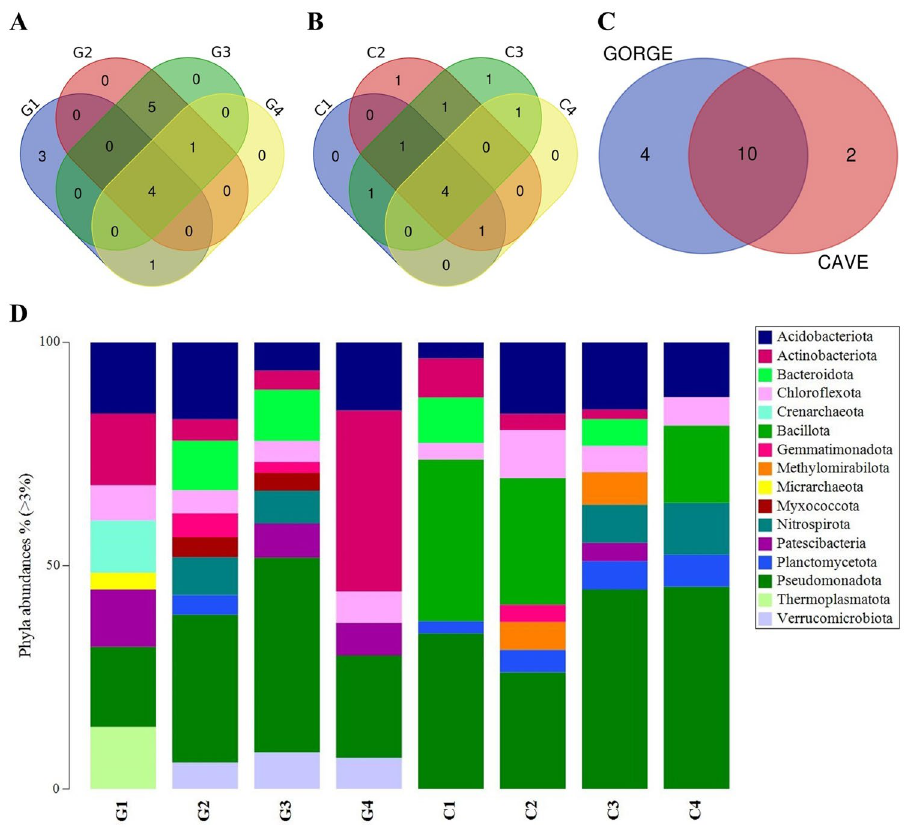
Figure 3. Venn diagrams and taxonomy barplot of ASVs at phylum level. Venn diagrams show common phyla found within gorge ( A ) and cave ( B ) samples and between the two groups (gorge vs cave). Taxonomy barplot shows the abundances (%) of main phyla in each sample ( D ) (cutoff 3%).